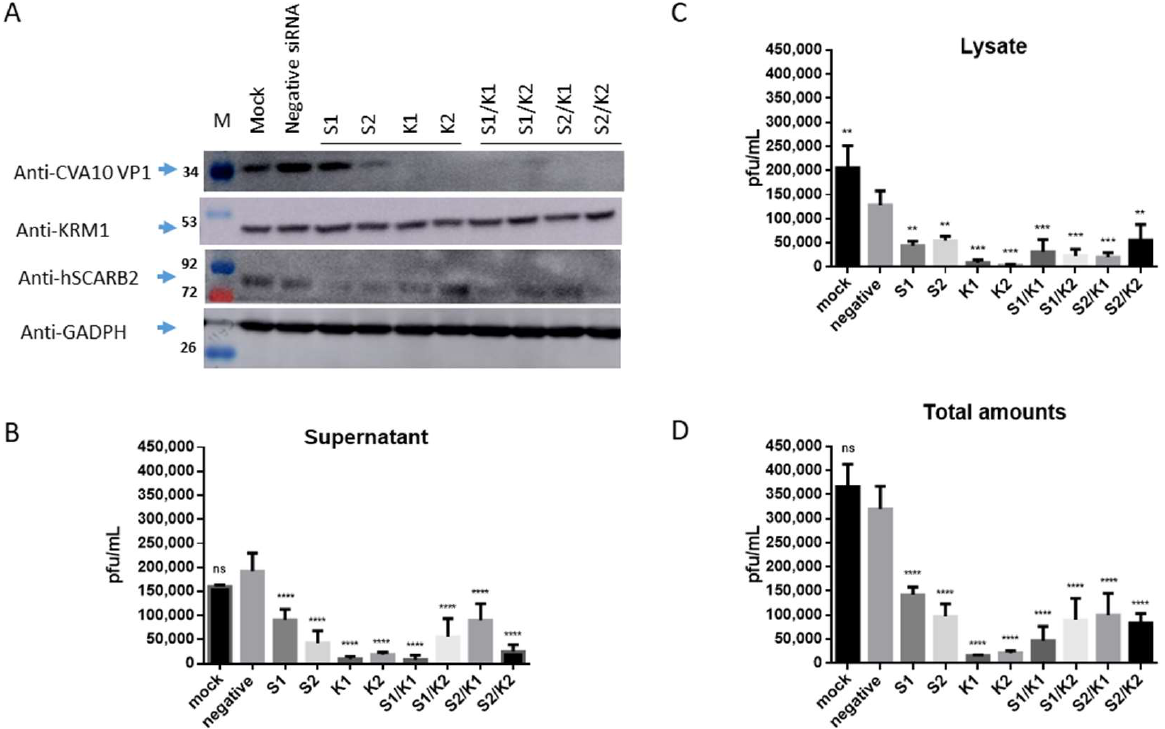
Figure 3. The reduction of endogenous hSCARB2 and KRM1 expression impacted CVA10 infection. RD Cells were transfected individually with 50 pmoles of siRNA specific to hSCARB2 (s2651(S1) and s2652(S2)), KRM1 (s38393(K1) and s38394(K2)), or mixed specific siRNA with equal amounts (50 + 50 pmoles) of S1 + K1, S1 + K2, S2 + K1, S2 + K2, or negative siRNA, followed by 48 h of incu- bation. Infection of siRNA-treated cells with CVA10 (MOI = 0.05) and then cultured for another 24 of hSCARB2 or KRN1 in the cells. ( b ) The supernatant and ( c ) lysate were collected and subjected